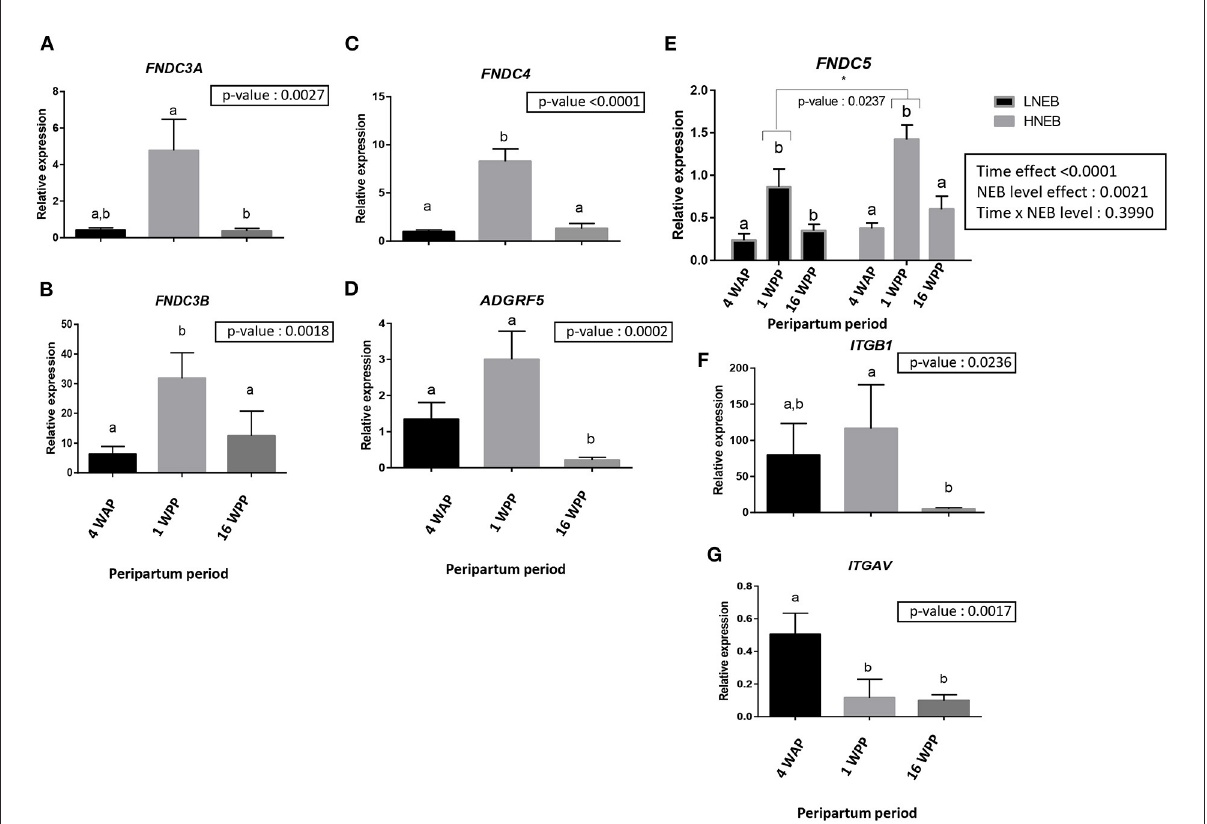
FIGURE5 Abundance of FNDC3A (A) , FNDC3B (B) , FNDC4 (C) , FNDC5 (E) , ITGAV (G) , ITGB1 (F) and ADGRF5 (D) mRNA in bovine subcutaneous adipose tissue during peripartum period. Tissues were obtained 4 weeks before parturition (4WAP) and 1 (1WPP) and 16 weeks post-partum (16 WPP) and mRNA measured by real-time RT-qPCR. Data are expressed as mean ± SEM for each group ( n = 8 in LNEB group and n = 13 in HNEB group) and analysed by a nonparametric analysis of variance with repeated measures (Friedman test). Groups with different letters are significantly different ( p < 0.05). * indicates a significant difference ( p <